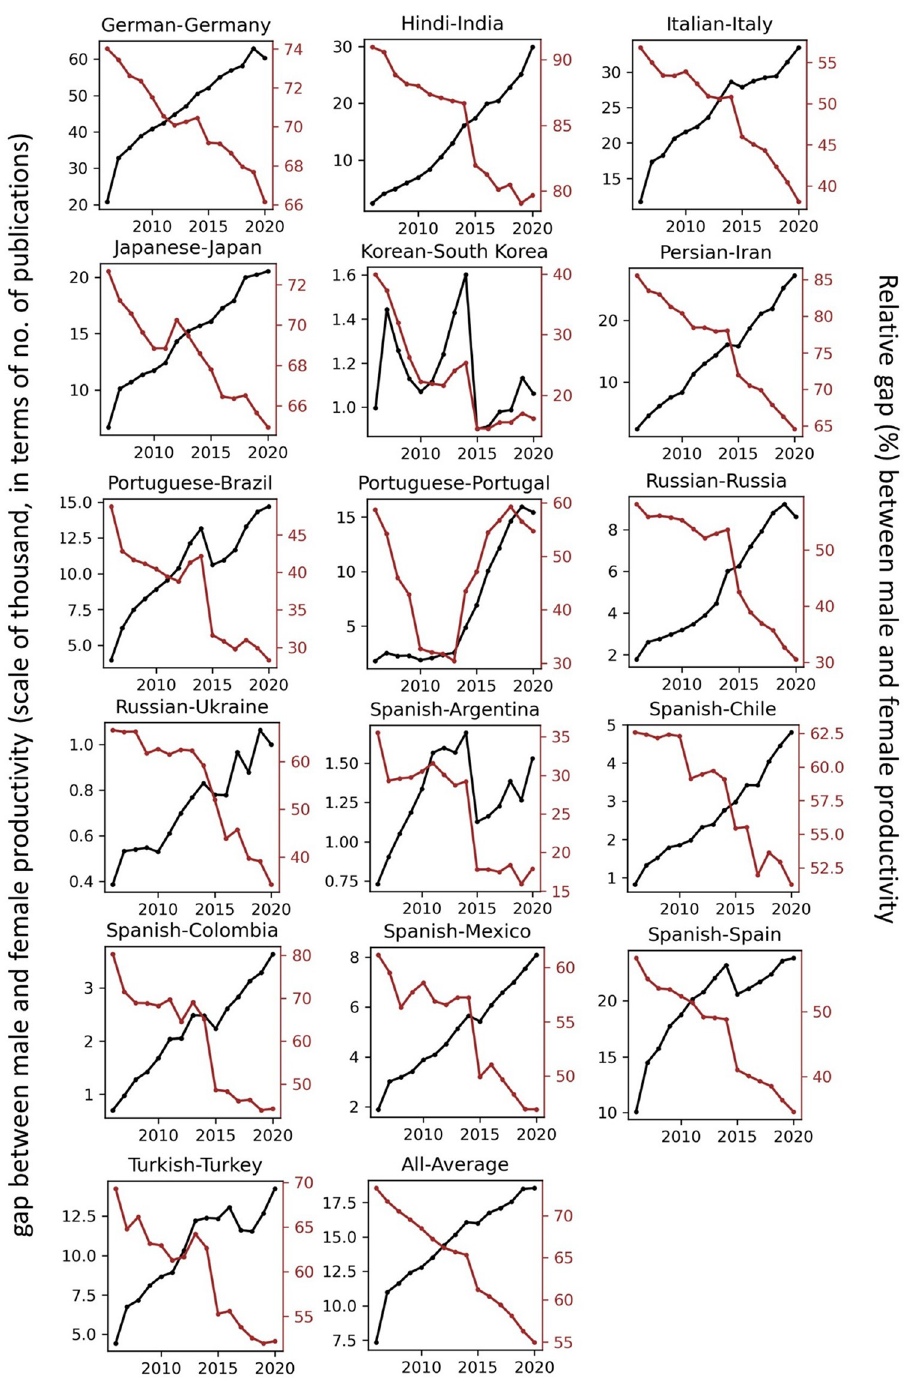
Fig 18. Gaps between male and female total research productivity, A-Z method (part